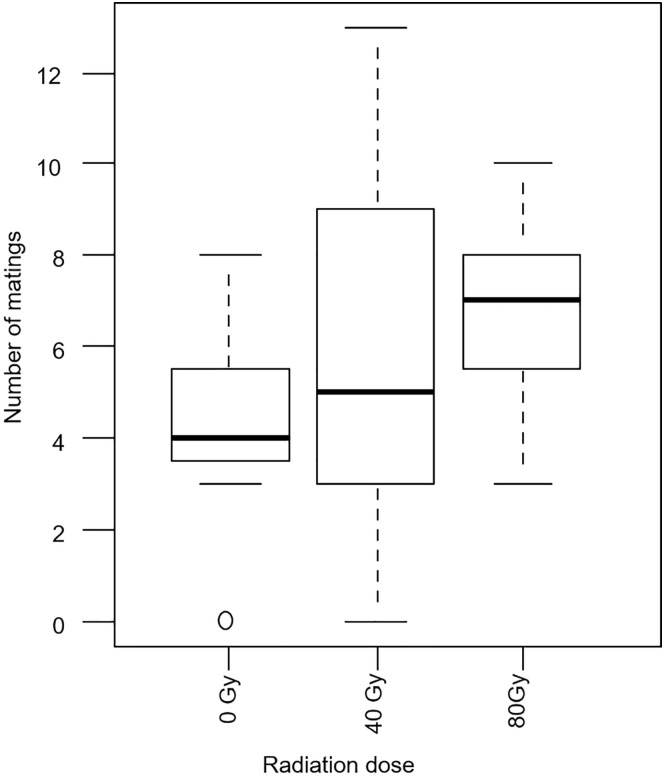
Number of irradiated male (40 or 80 Gy) and untreated male (0 Gy) Glossina brevipalpis that mated with untreated females in a field cage.Each box shows the group median separating the 25th and 75th quartiles, capped bars indicate maximum and minimum values, circles indicating the outliners.